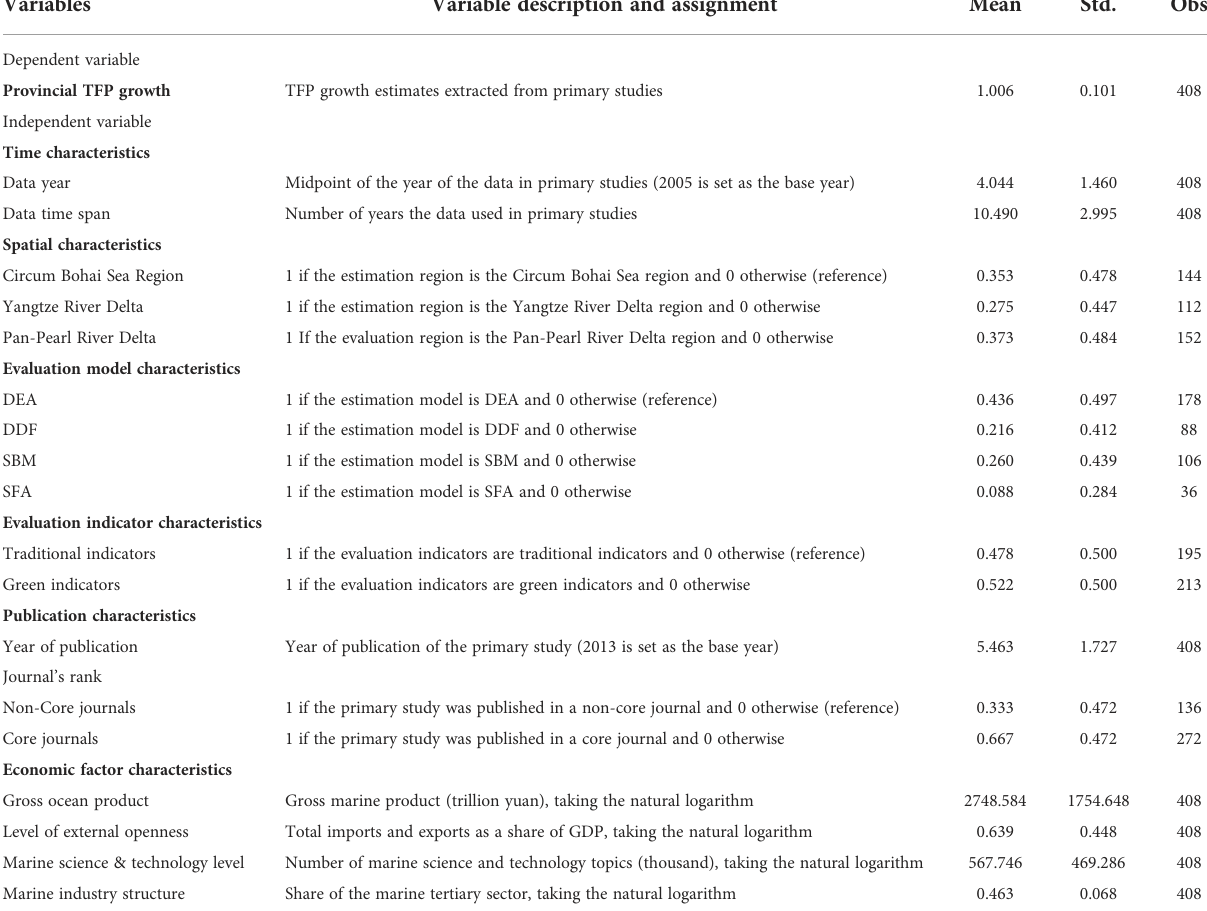
TABLE 2 Results of descriptive statistics of characteristic variables that incorporate with subsequent meta-regression analysis at the provincial level.